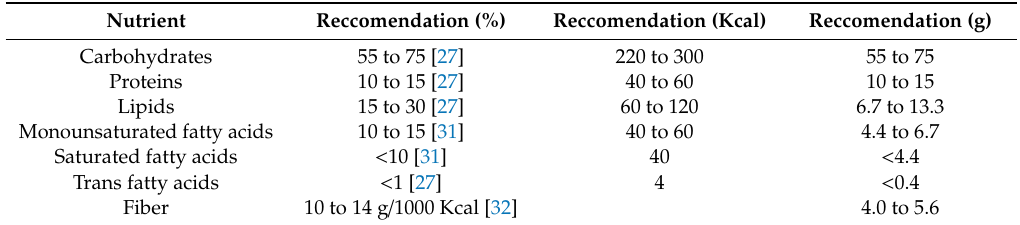
Table 1. Distribution of macronutrient recommendations on total energetic value (TEV) of 400 kcal of